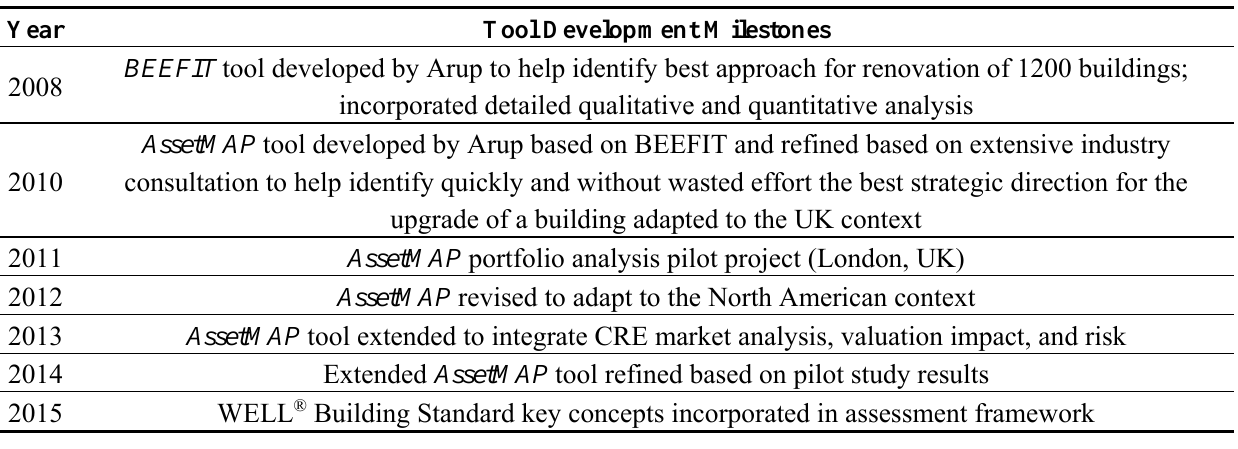
Table 1. Framework